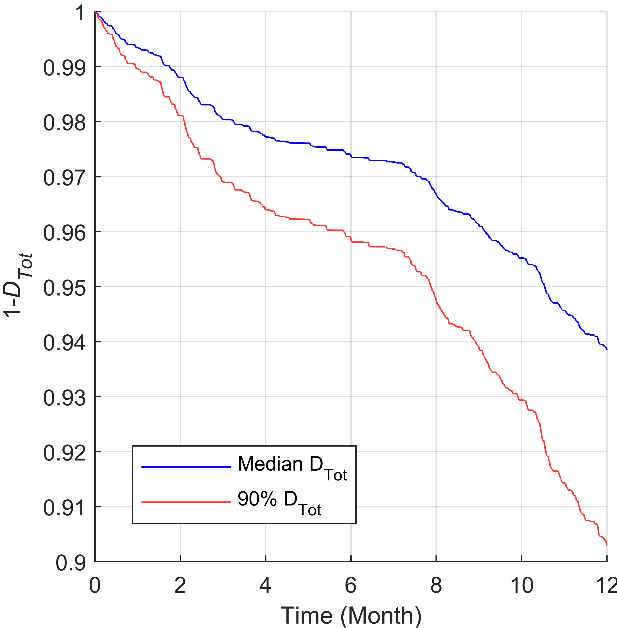
Figure 13. Graphic of 1 − D Tot for 1 WT imposing TI = 12% for a 1-year period. In blue, the median D Tot , computed with the 50th percentile of D HCF . In red, 90% D Tot , computed with the 90th percentile of D HCF .